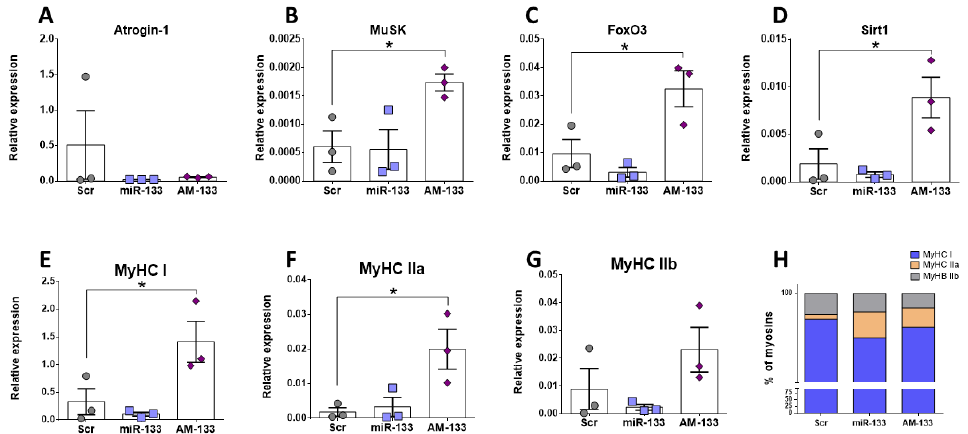
Figure 7. Expression (relative to 18S) analysis of marker genes for MyHC composition, atrophy and NMJ formation in C2C12 cells treated with Scr control, miR-133 mimic or anatgomiR-133 (AM-133). Gene expression was analysed for Atrogin-1 ( A ), MuSK ( B ), FoxO3 ( C ), Sirt1 ( D ), MyHC I ( E ), MyHC IIa ( F ), MyHC IIb ( G ). Myosin percentages are shown in ( H ). * p ≤ 0.05 (mean ± SD; n = 3).